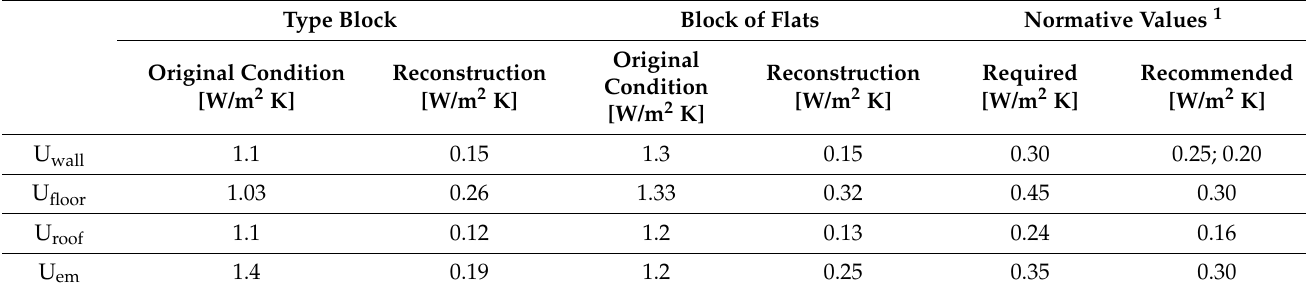
Table 5. Comparison of heat transfer coefficients (for the original condition and the condition after